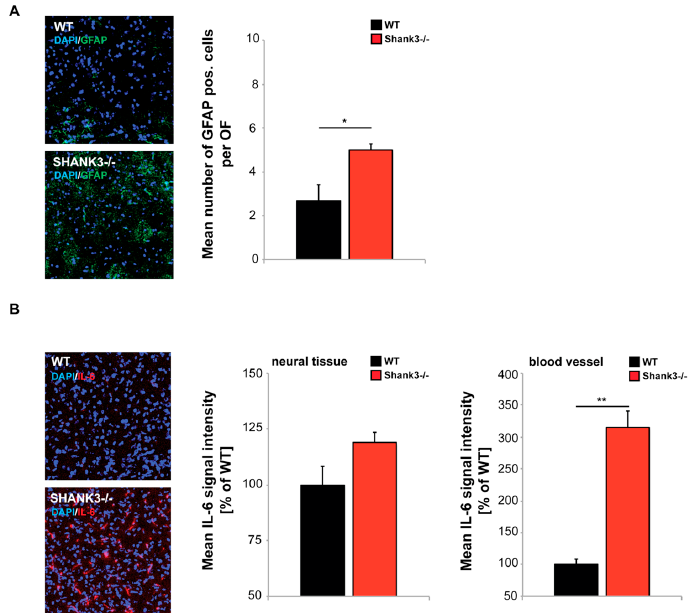
Figure 4. Confocal microscopy images with same acquisition time taken from frontal cortex of brain sections from WT and Shank3 αβ KO mice ( n = 3 animals per group) were used to assess the number of activated astrocytes labeled by Glial fibrillary acidic protein (GFAP), and IL-6 levels in neural tissue